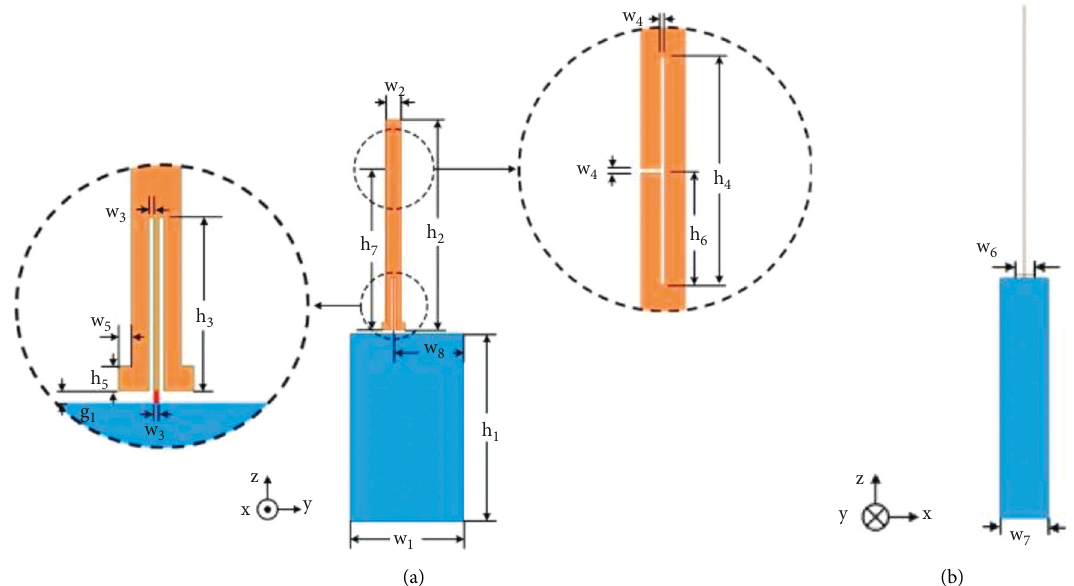
Figure 2: The dimensions of the proposed antenna. (a) The front view of the antenna (the left inset is the magnifying view of the slim strip and the rectangular plates near the feed point of the antenna, and the right inset is the magnifying view of the T-type slot on the upper half of the radiated strip). (b) The left view of the